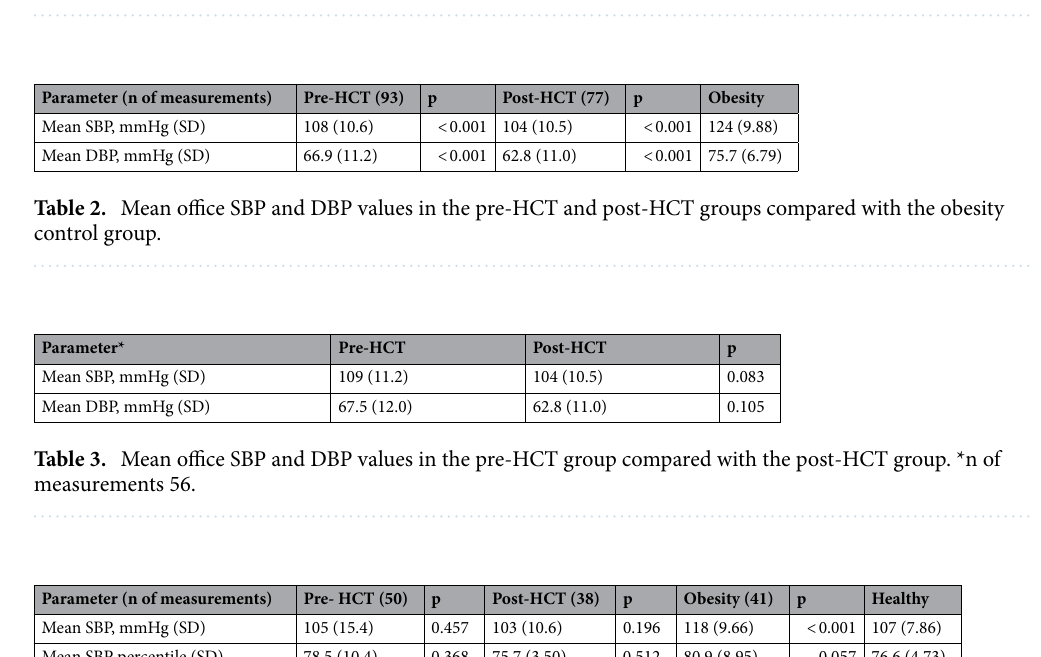
Table 1. Mean office SBP and DBP values in the pre-HCT group, post-HCT group and obesity control group, compared with the healthy control group.